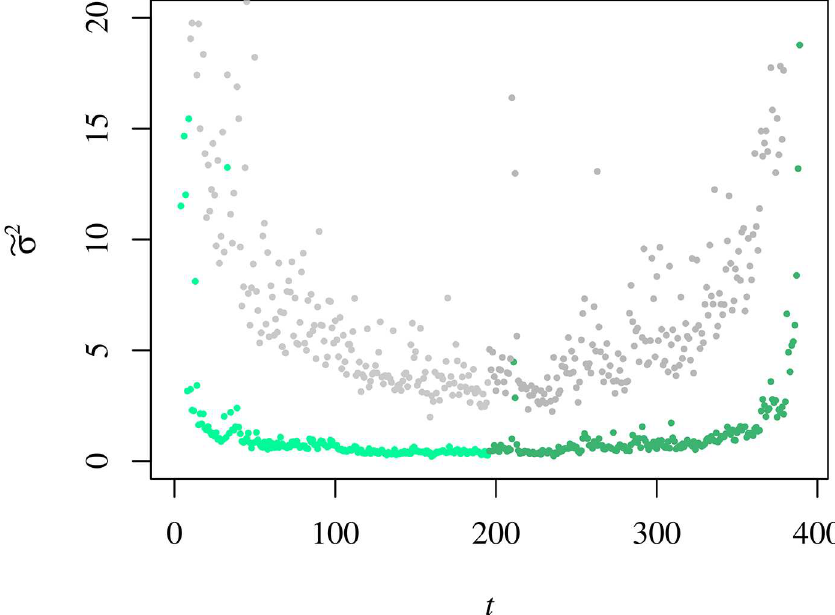
Fig 13. Cross-sectional variance v intra-day time in 2S08. As employedfor the individualanalysis we use the lighter(darker) tone of green for the morning(afternoon) part of the curves ^ s 2 ð t ;2 S 08 Þ . For mere comparative purposes we present the individualanalysis ~ s 2 ð t ;2 S 08 Þ in